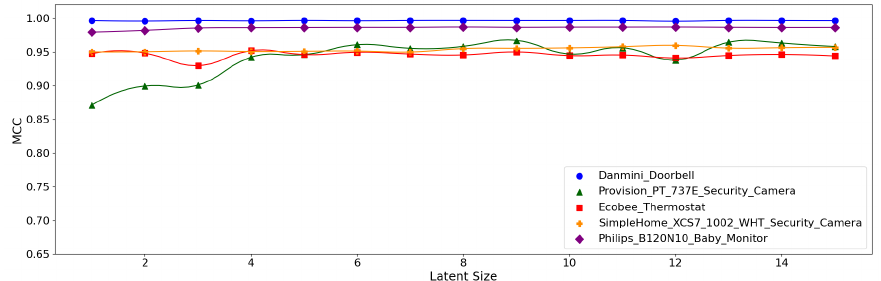
Figure 14. MCC per device for the N-BaIoT dataset when the (7,64) model is employed.